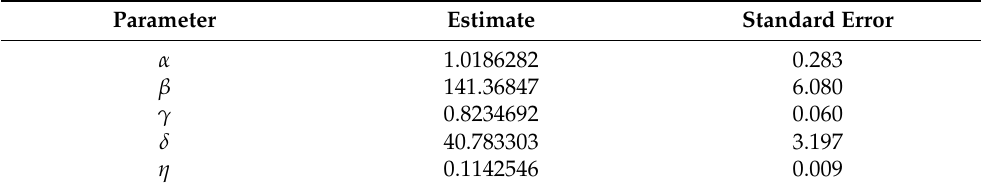
Table 3. Parameter estimates for “survival curve” (1) and distance decay function (2) ( R 2 = 0.9973). Parameter Estimate Standard Error α